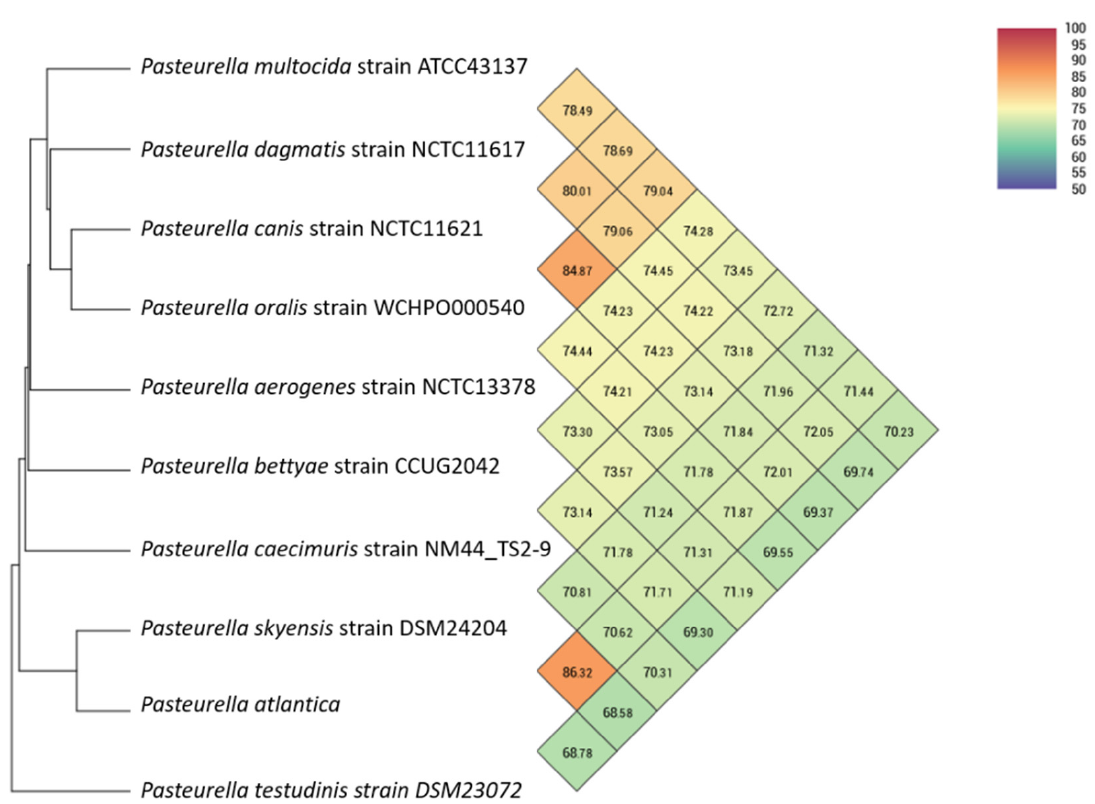
Figure 1. Heatmap generated with OrthoANI values calculated from the Orthologous Average Nucleotide Identity Tool (OAT) software.